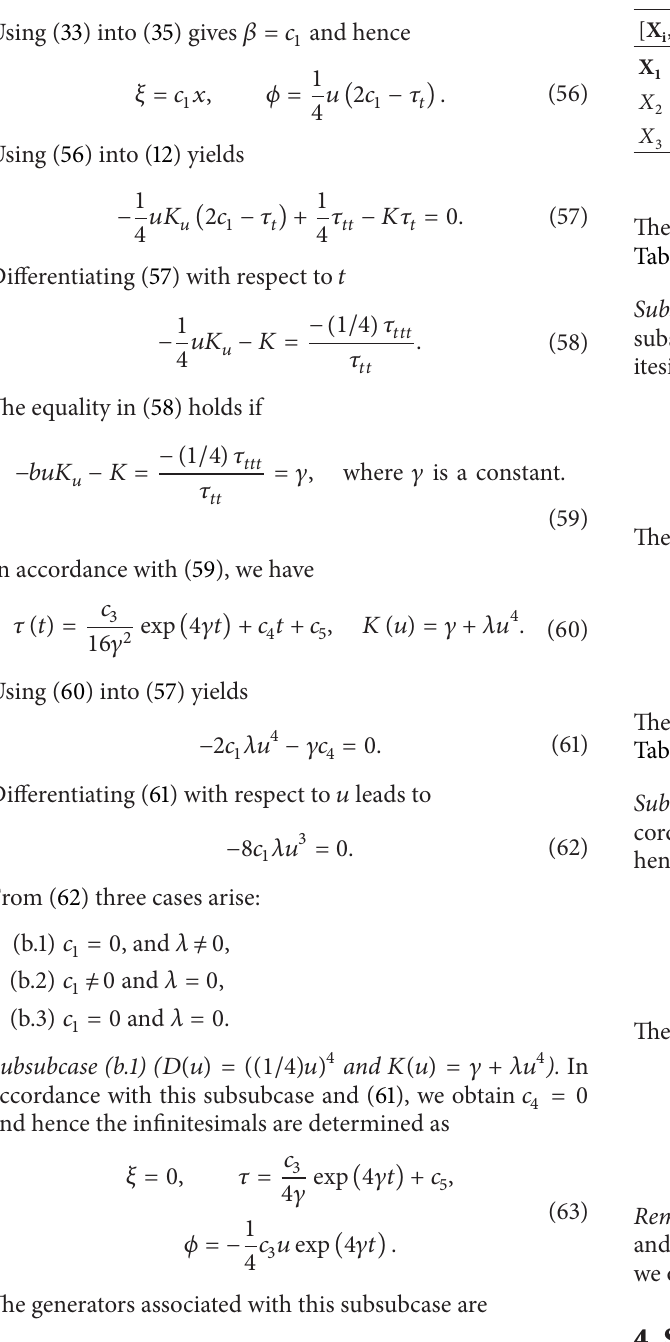
Table 6: Commutator table of the tumor equation.